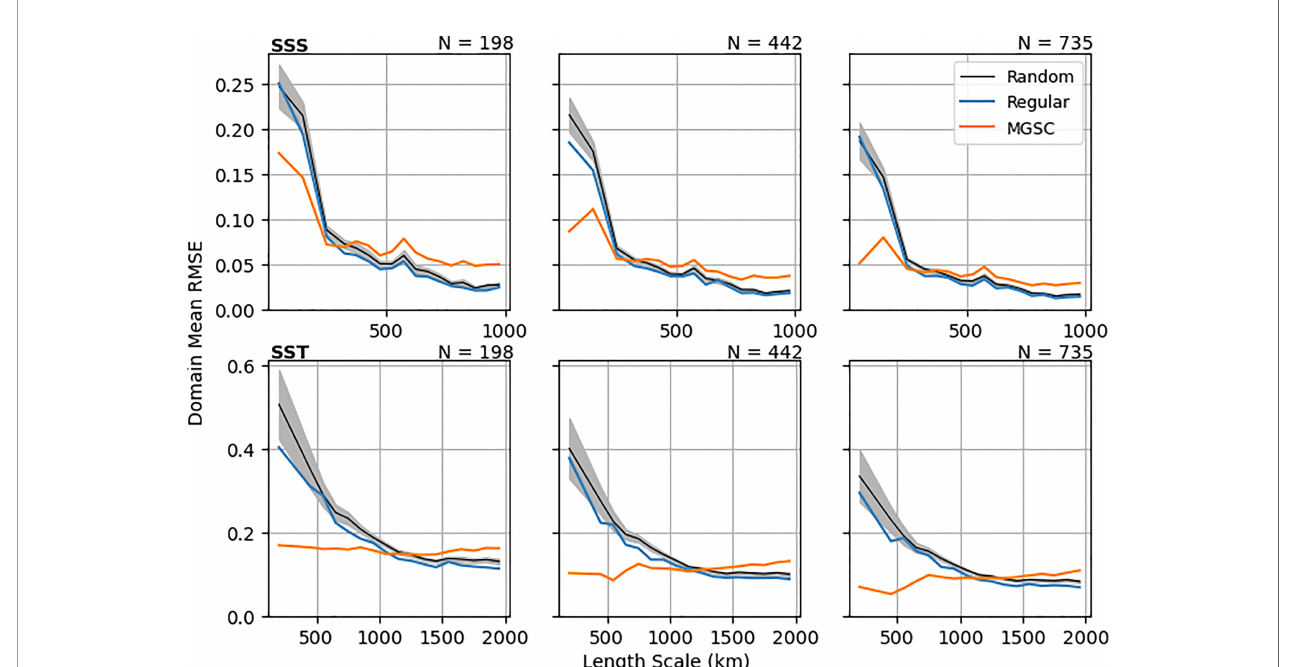
FIGURE 7 | Area mean RMSE resulting from a 10 year data construction using simple linear regression. Means are calculated in length scale bins. Three different numbers of observations are considered (columns): N=198, 442 and 735. These values match up with the numbers of points in three different regular observation grids. For the random placements, lines show the ensemble mean and the shaded areas show 1 standard deviation either side of the